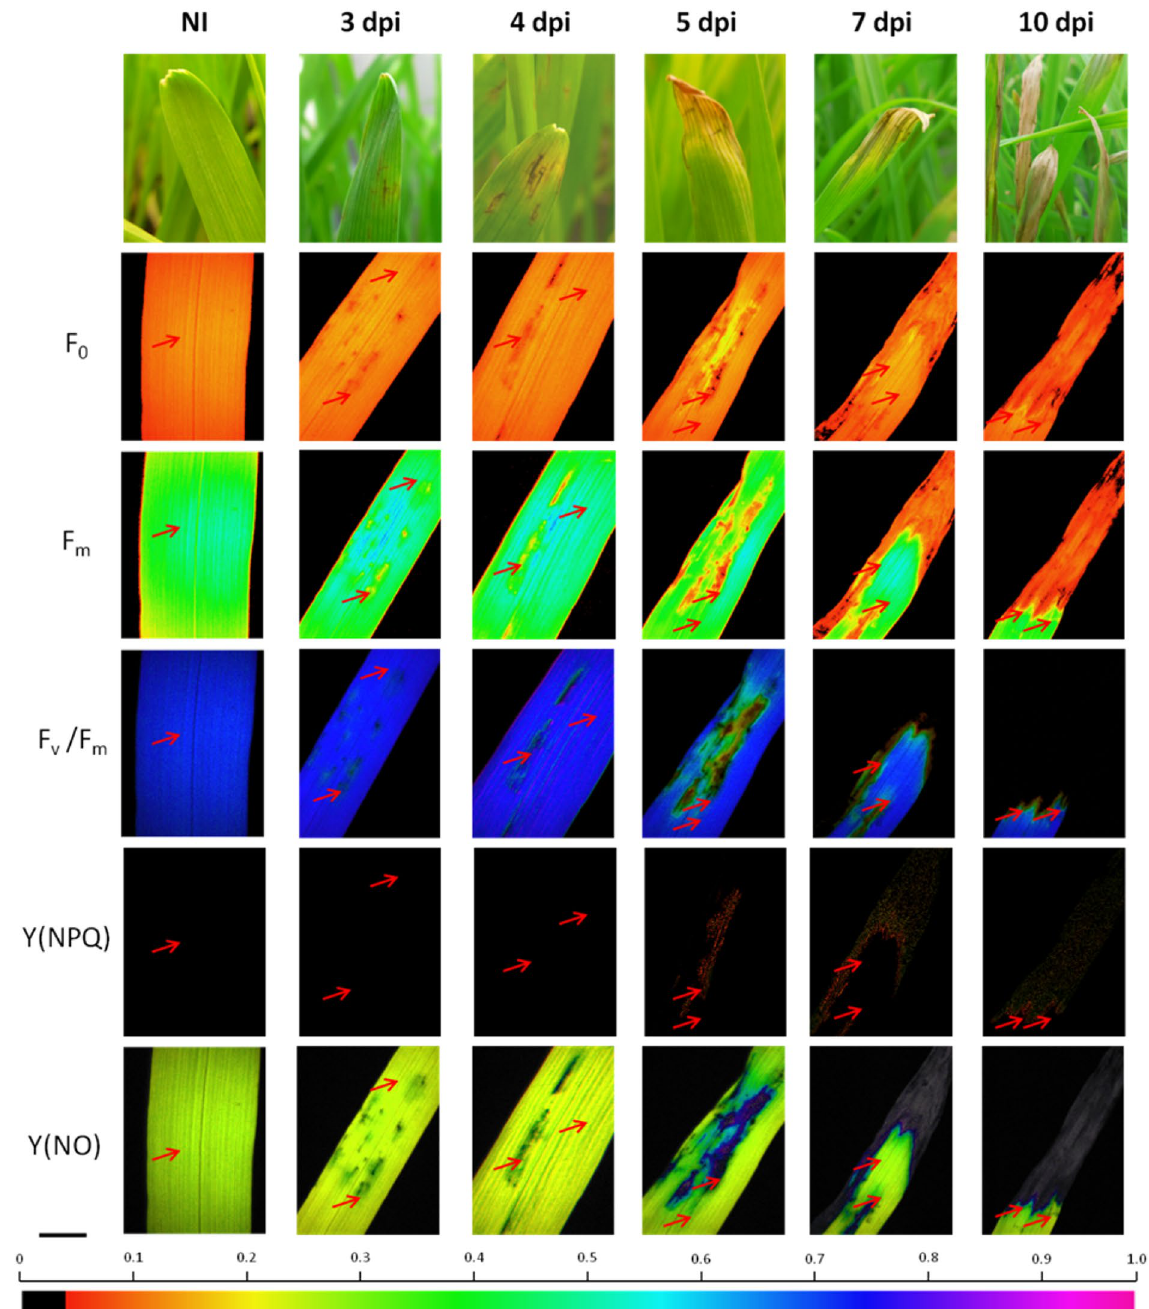
Figure 1. Parameters of chlorophyll a fluorescence (F 0 ), maximal fluorescence (F m ), maximal photosystem II quantum yield (F v /F m ), the quantum yield of regulated non-photochemical energy loss Y(NPQ) and quantum yield of non-regulated energy dissipation Y(NO) determined on the leaflets of barley plants non inoculated (NI) or inoculated with D. teres at 3, 4, 5, 7 and 10 dpi. The red arrows indicate the measurement zones. Bar 0.5